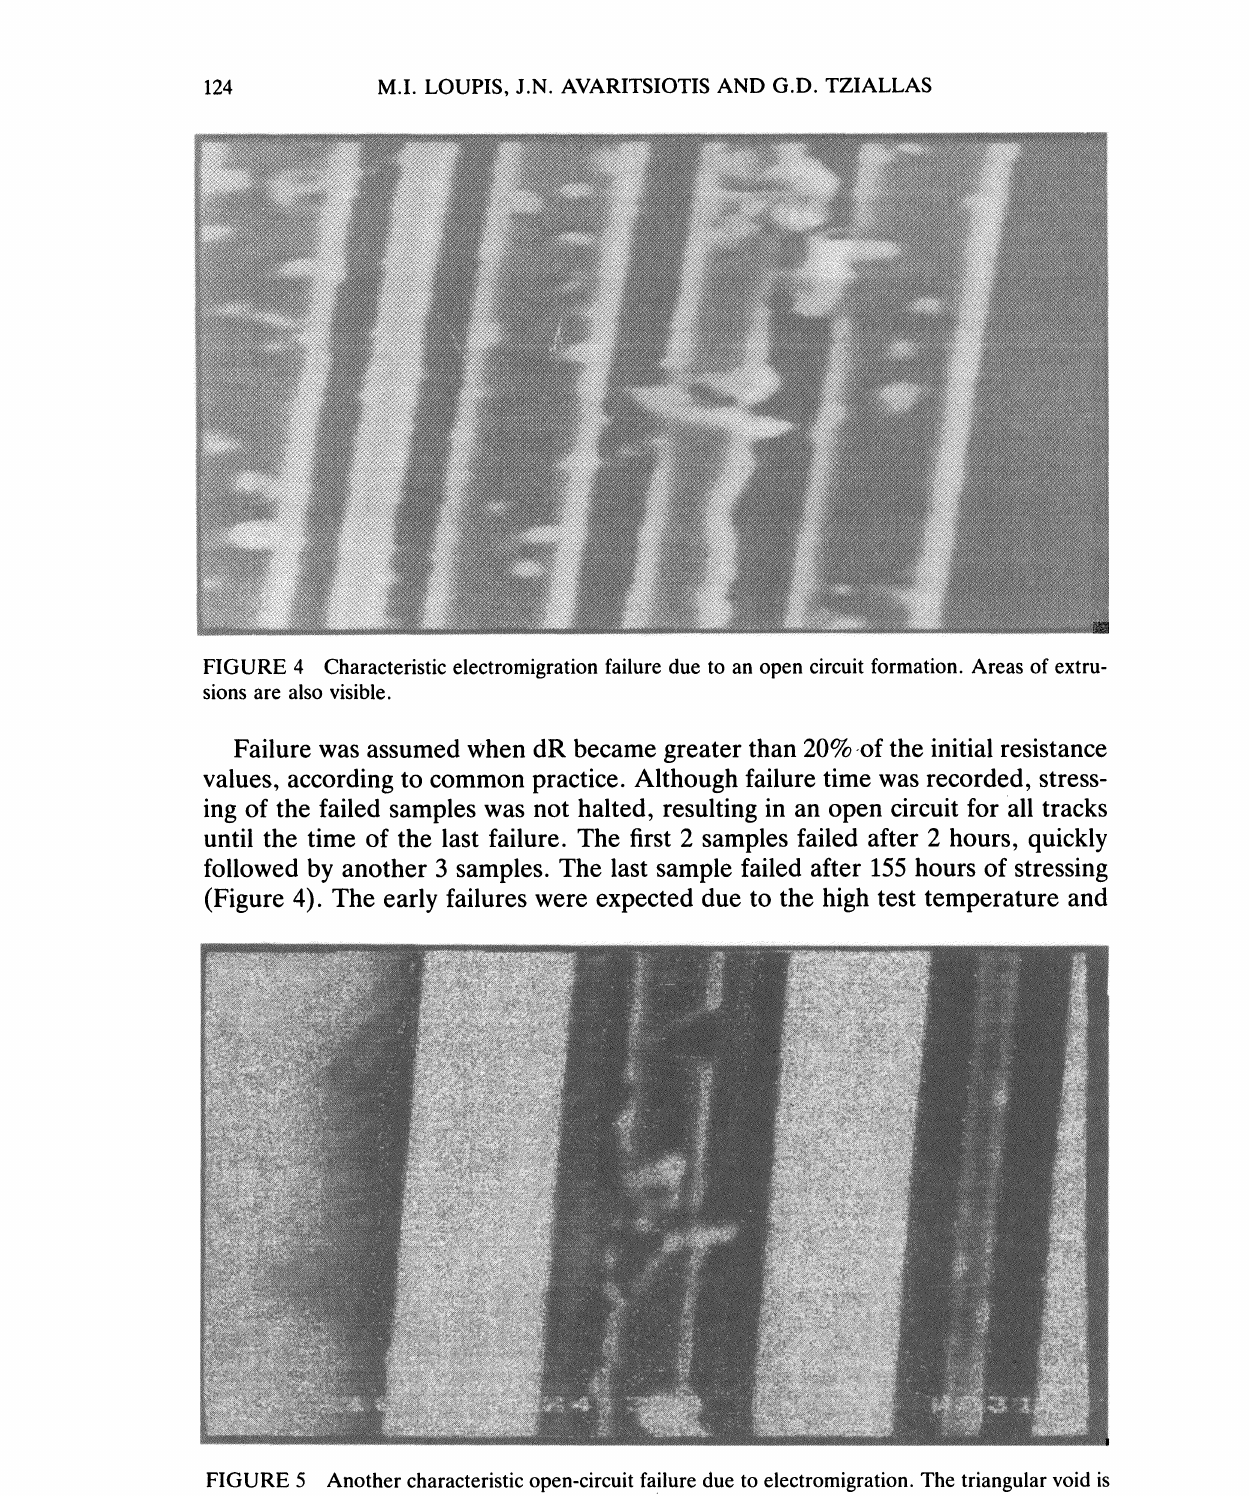
FIGURE 5 Another characteristic open-circuit failure due to electromigration. The triangular void is due to the thermal stress that preceded the electr0migration